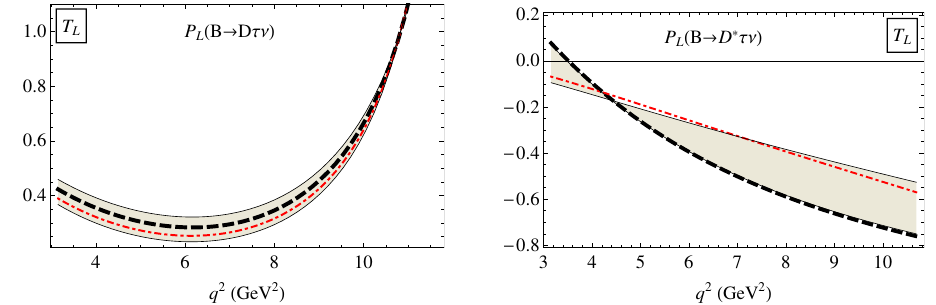
Figure 7. Longitudinal polarization of the τ in the decays B 0 → D τν ( left ) and B 0 → D ∗ τν ( right ) in the tensor scenario. Notations are the same as in Figure 6. Table 4. The q 2 average of the longitudinal polarization in the SM and in the presence of NP. < P τ ( D ) > < P τ ( D ∗ ) > < P τ ( η c ) > < P τ ( J / ψ ) > L L L L S M 0.33 − 0.50 0.36